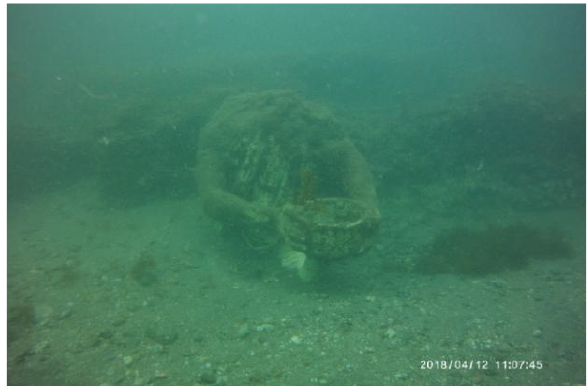
Figure 2 (a). The “Nymphaeum of Punta Epitaffio” before the dredging operations.